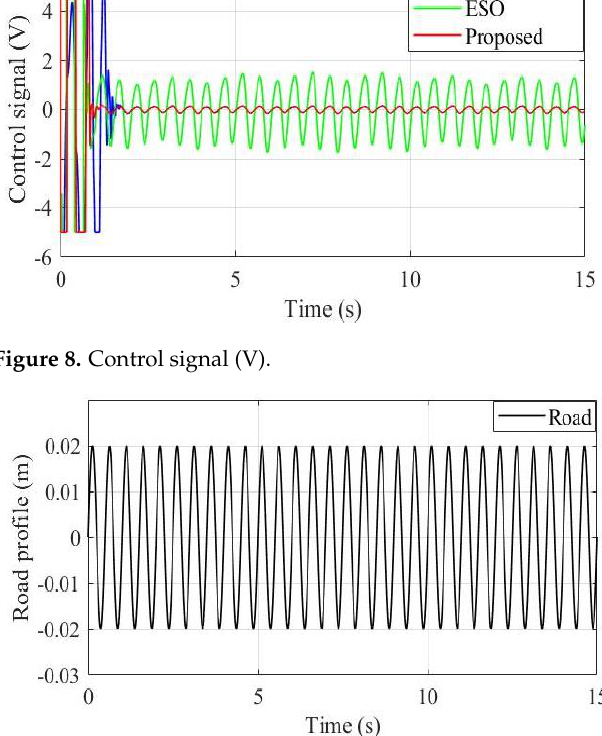
Figure 9. Road profile.